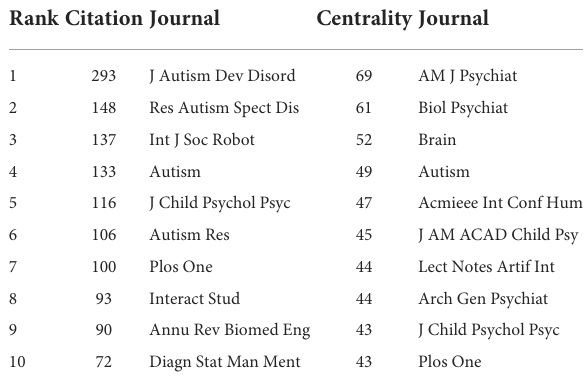
TABLE 7 Top 10 co-cited journals related to AI on